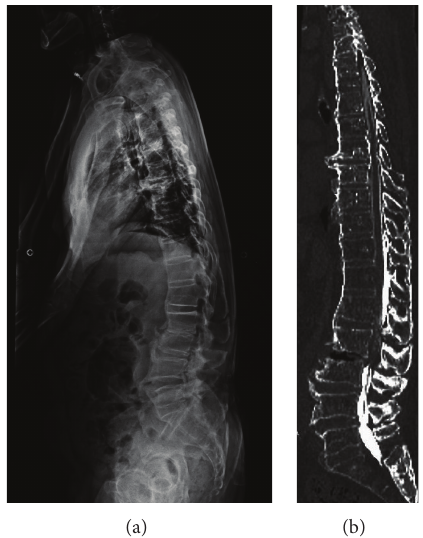
Figure 1: (a) Length in the standing position and lateral image in the standing position. (b) CT-MPR of the total length of the spine. The lateral X-ray image in the standing position showed no L2-L3 intervertebral space, but CT-multiplanar reconstruction images in the dorsal position showed a clearly opened L2-L3 intervertebral space.